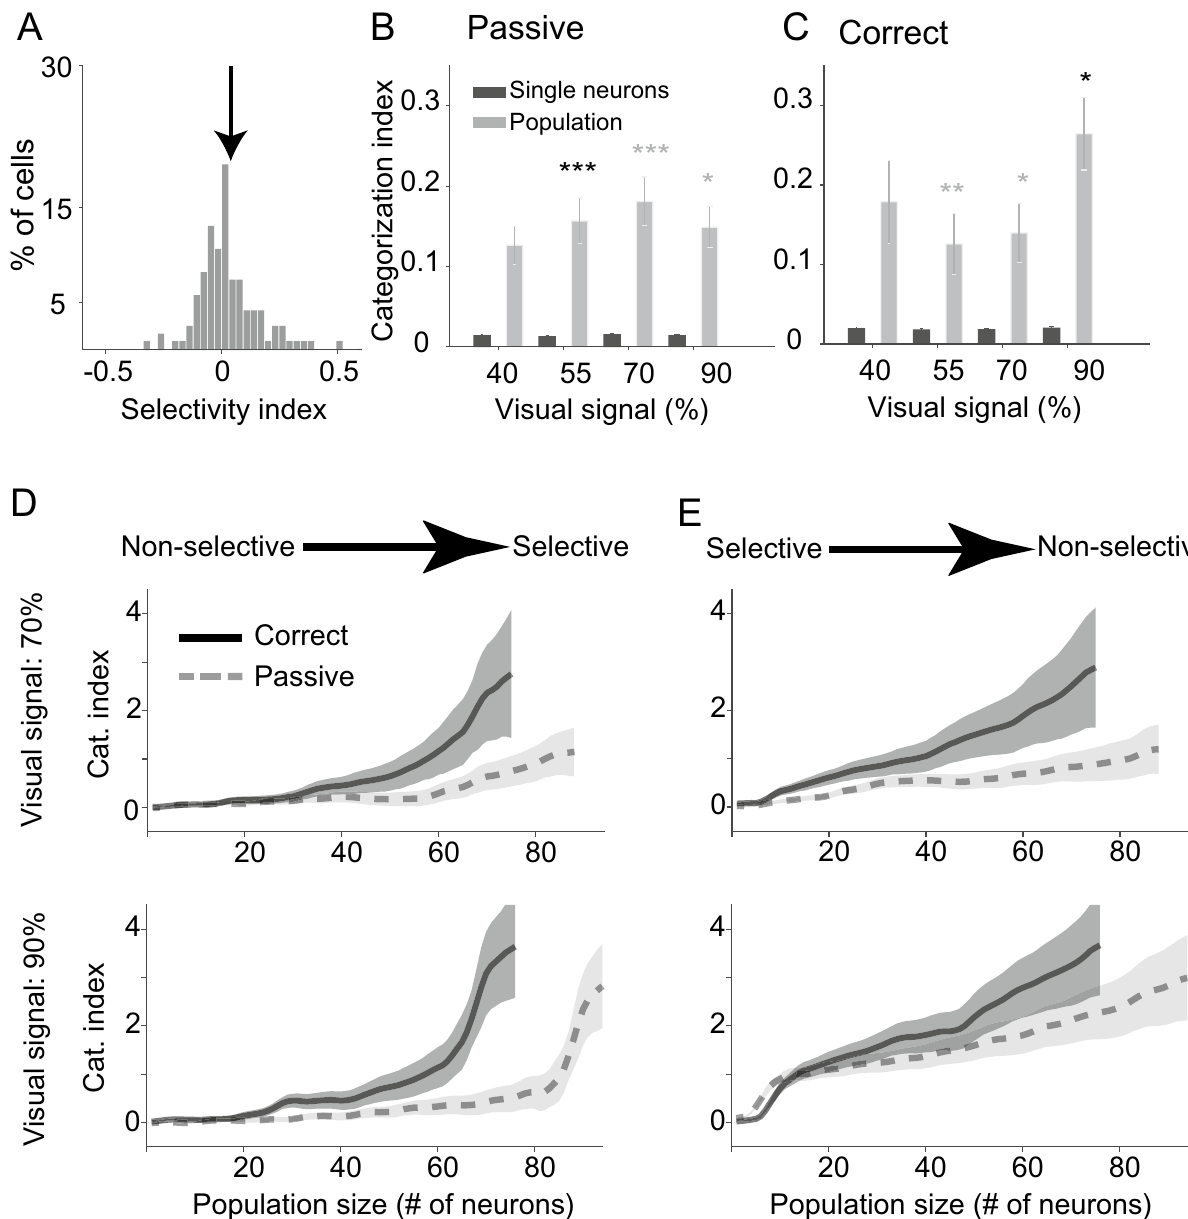
Figure 7. Comparison of category information conveyed by non-selective neurons computed for neural population and unit activities. The distribution of the selectivity index ( A ) is shown for all neurons. Arrow indicates the mean of selectivity index. Mean category information from 150 to 350 ms after stimulus onset calculated by CI in passive ( B ) and correct ( C ) trials are shown for the individual units and the neural population in non-selective neurons. Error bars represent the STD of bootstrap samples in population and SE in single neuron sub-plots. ( D , E ) Plots show the categorization index of the population of neurons as a function of the number of single units used for making the populations. Neurons were sorted based on SI, and sets of neural population were made by subsequently adding new units with increasing ( D ) and decreasing ( E ) SI values. Significance was computed with a bootstrap method to estimate 95%, 99%, and 99.9% confidence intervals. Asterisks indicate a significant difference between groups with different neural selectivity (* p < 0.05, ** p < 0.01, *** p <